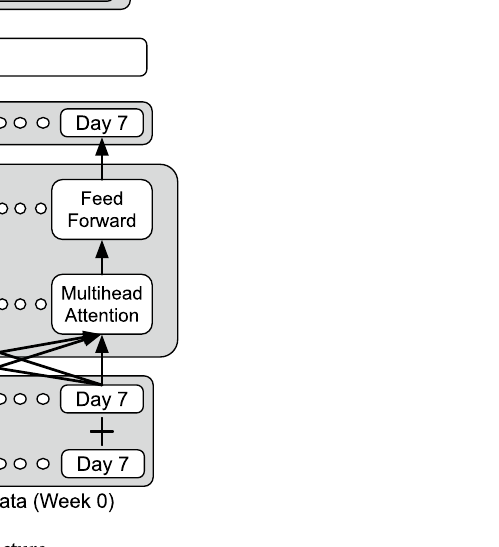
Figure 2. Transformer based model